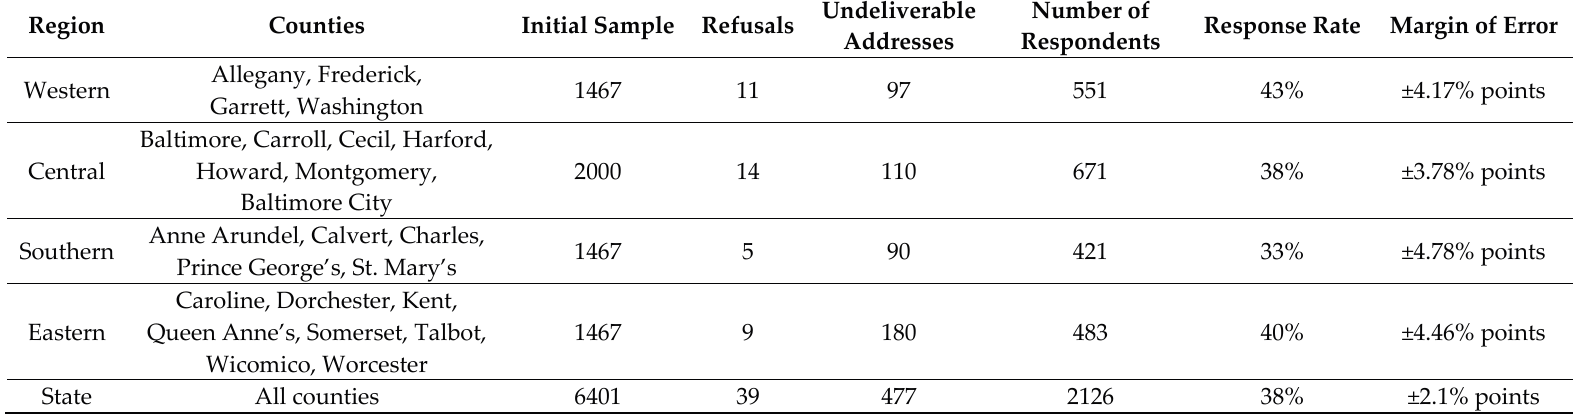
Table S1. Regional samples, response rates and margin of error.